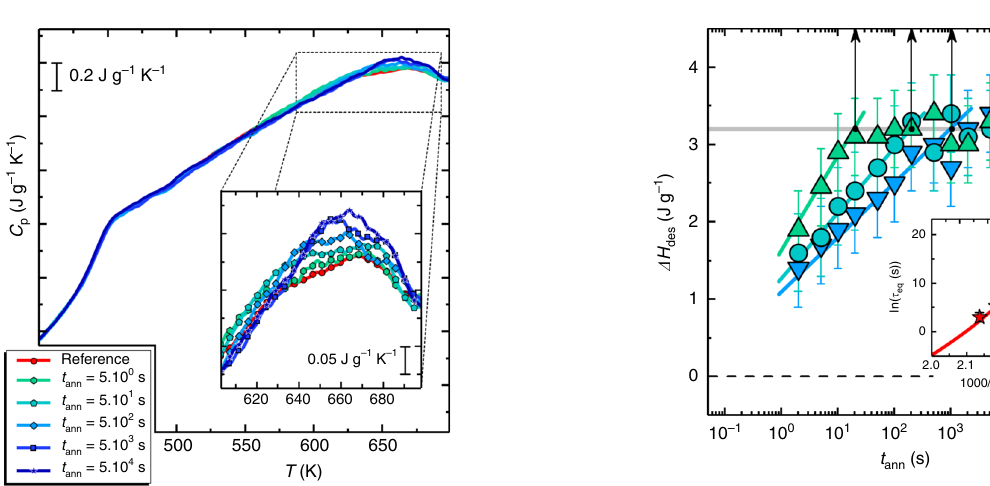
Fig. 3 Dependence of the heat of desorption on annealing. Heating scans at 10 4 K s − 1 after annealing at 458 K for various times. The inset is an enlargement in the temperature range where desorption takes place.